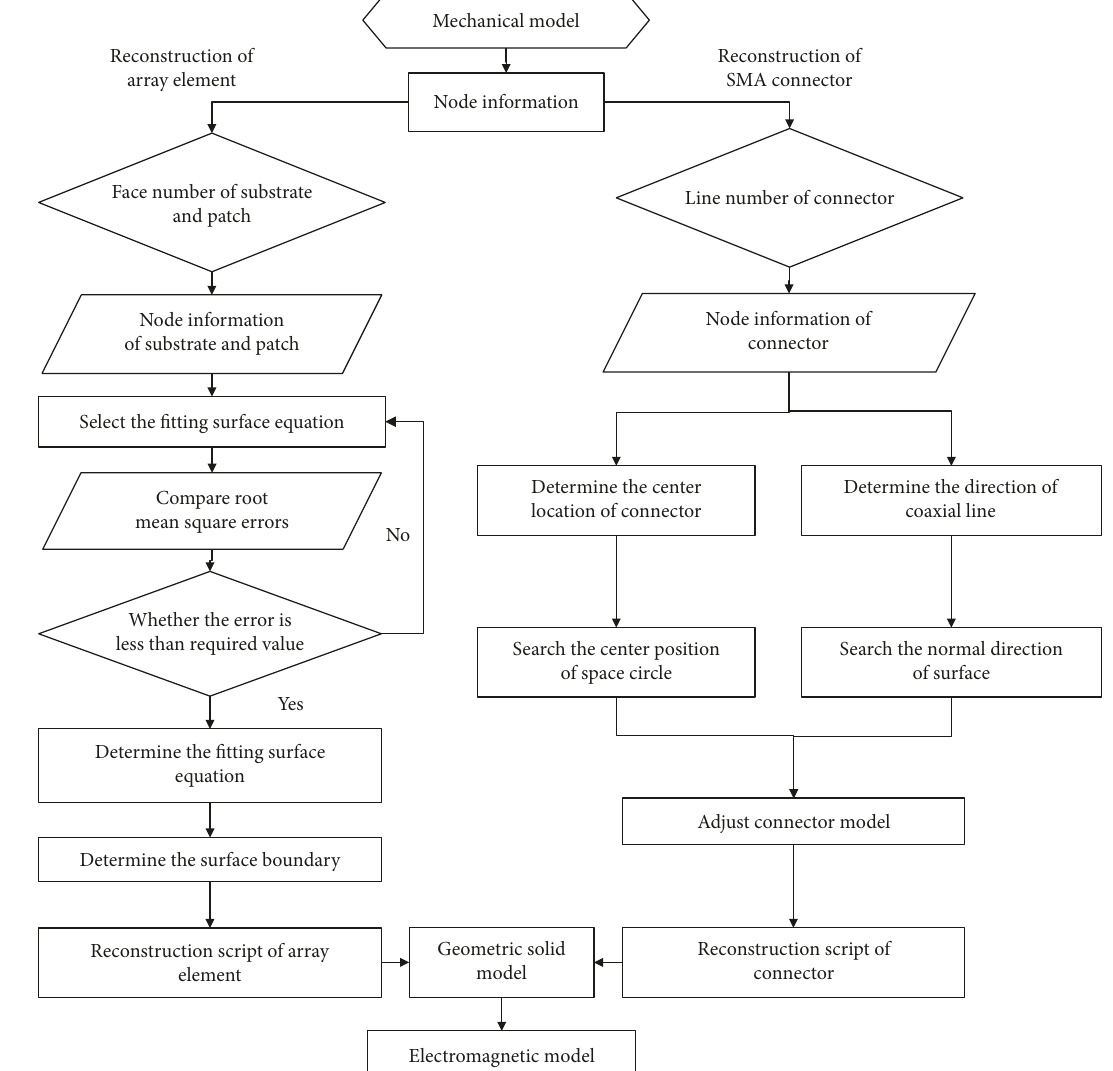
Figure 7: Reconstruction algorithm fl ow